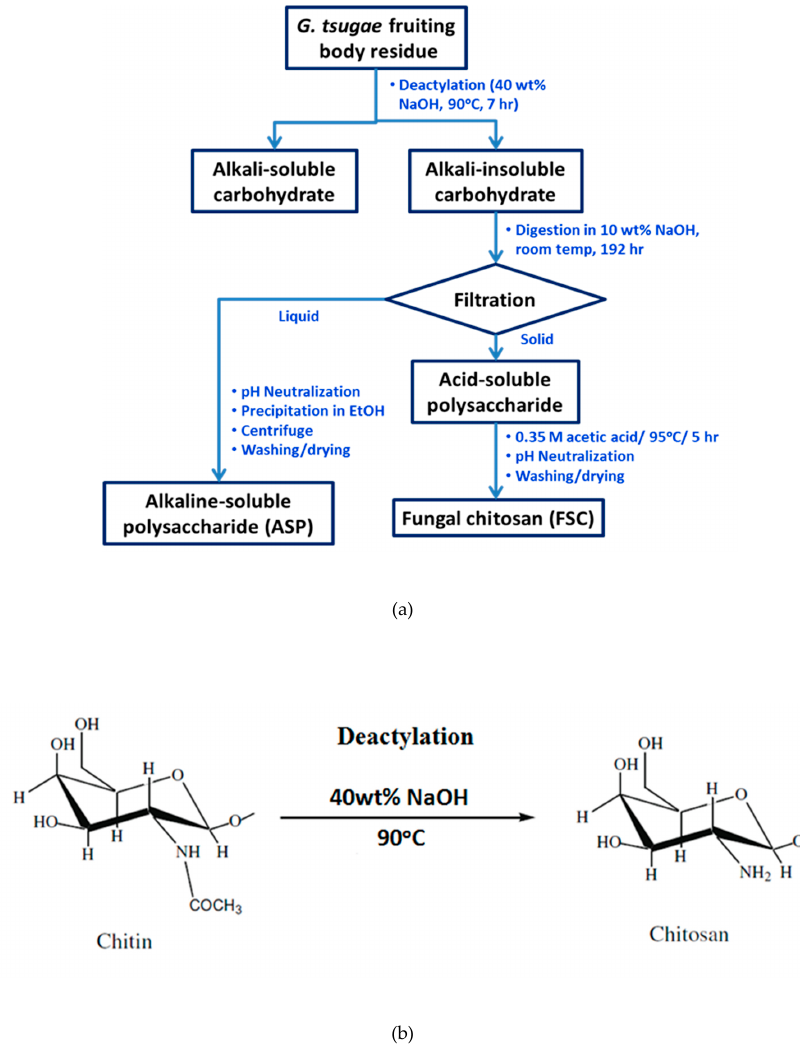
Figure 1. Flow diagram for alkali-soluble polysaccharide (ASP) and fungal chitosan (FSC) preparation: ( a ) flow diagram of ASP and FSC preparation; ( b ) deactylation of chitin for preparation of chitosan.